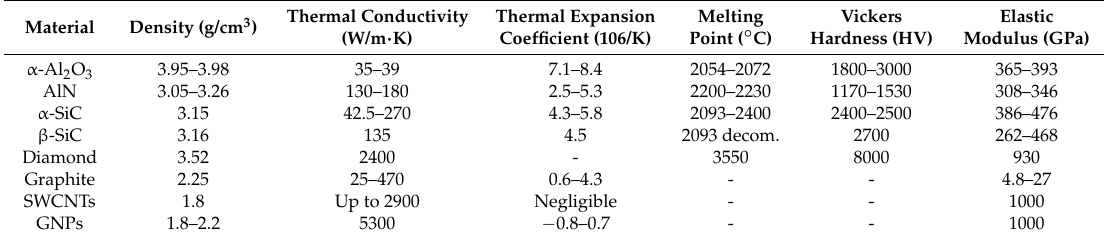
Table 2. The characteristics of common reinforcements, data from